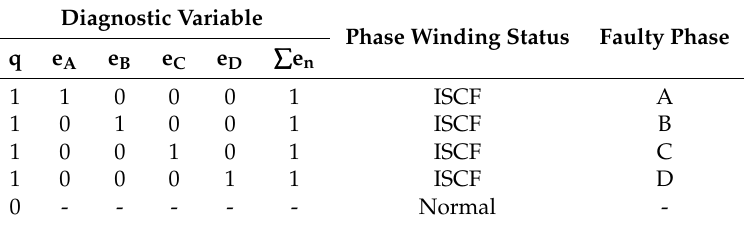
Table 1. Diagnostic variable for identifying the faulty phase.